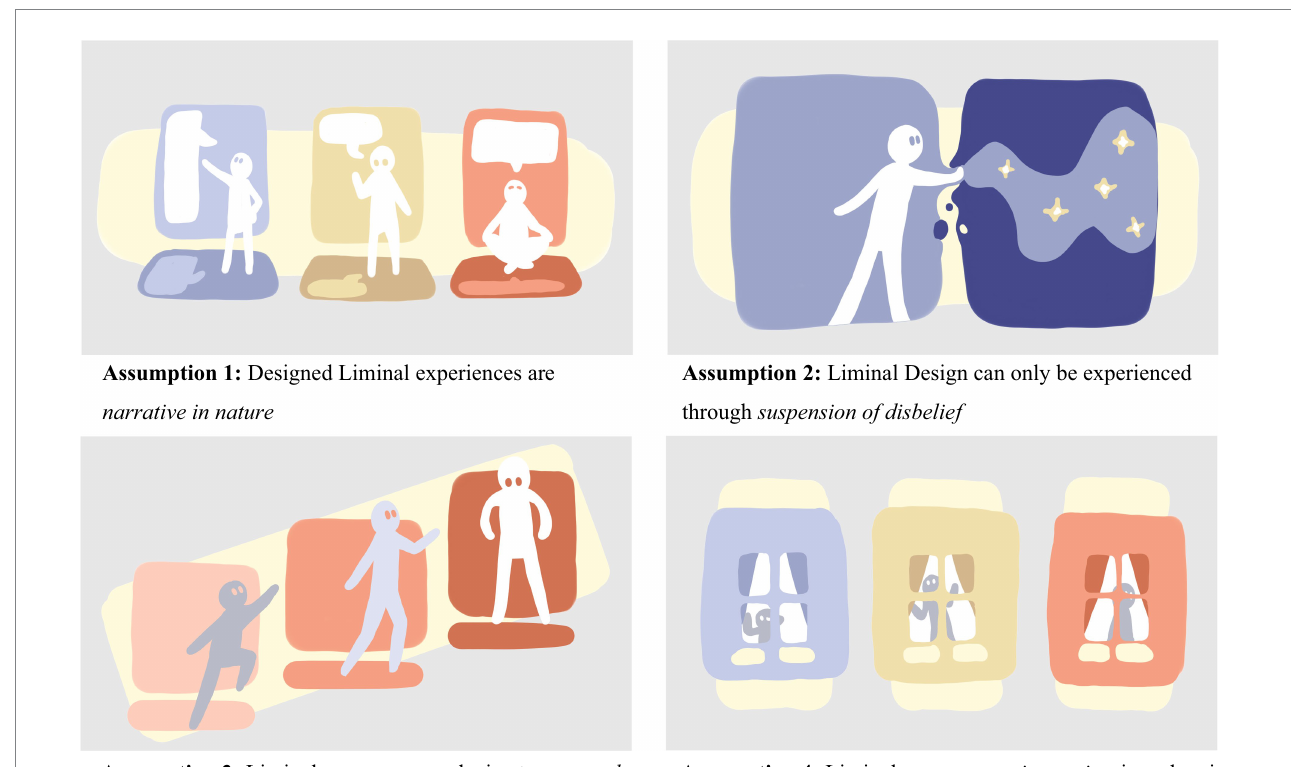
FIGURE 1 Four foundational assumptions of the Liminal Design